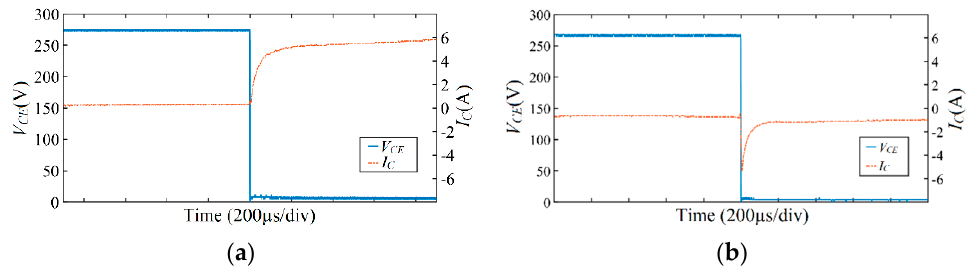
Figure 9. ( a ) V CE and I C waveforms during the turn-on transition of the high-side IGBT; ( b ) V CE and I C waveforms during the turn-on transition of the low-side IGBT. I C waveforms during the turn-on transition of the low-side